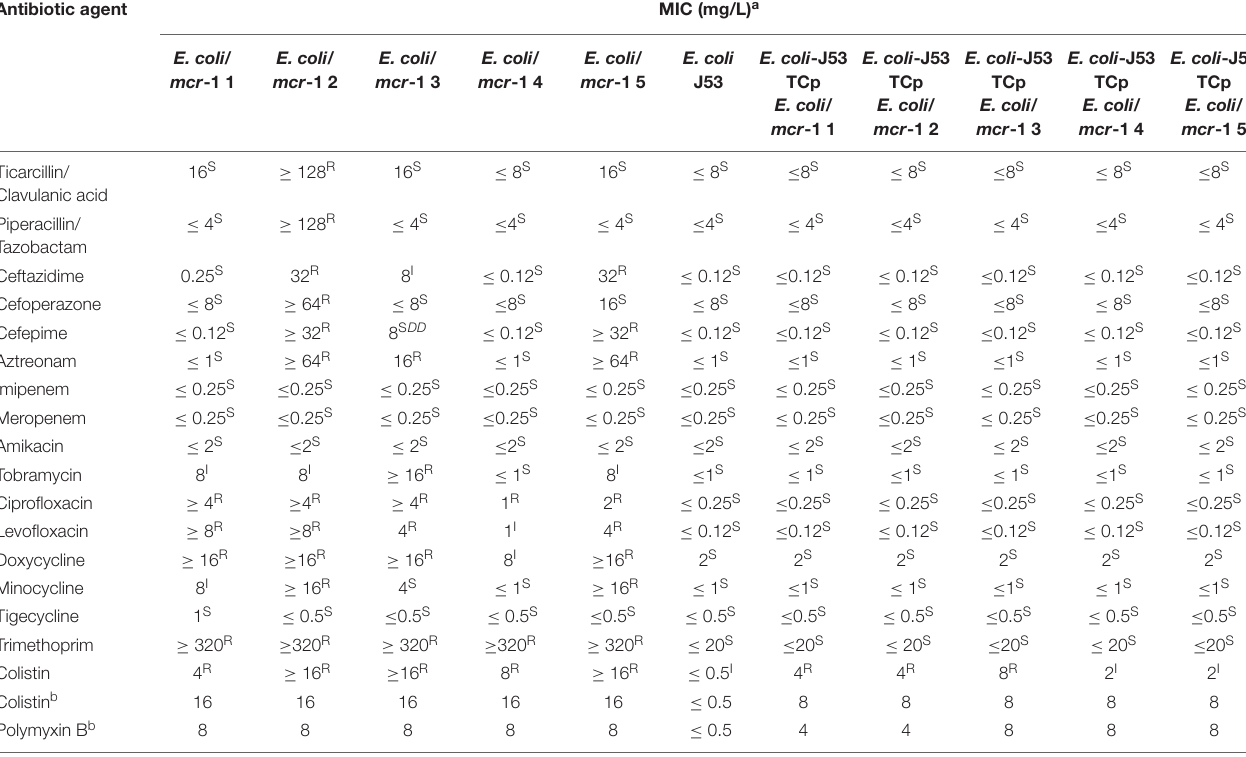
TABLE 4 | Bacterial susceptibilities to